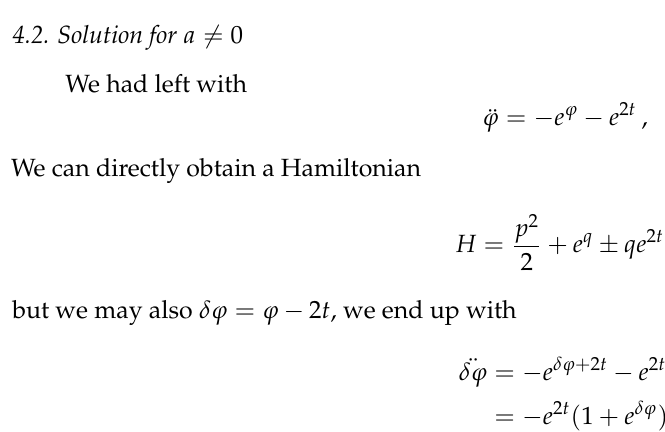
Figure 1. Phase portrait of Hamiltonian